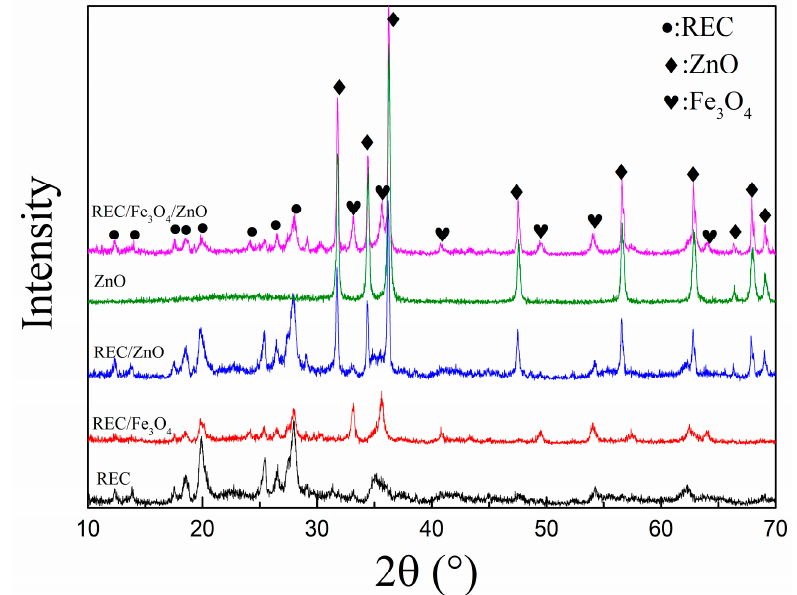
Figure 2. X ‐ ray diffraction (XRD) patterns of REC, ZnO, REC/ZnO (1:0.5), REC/Fe 3 O 4 (1:0.3) and REC/Fe 3 O 4 /ZnO (1:0.3:0.5).